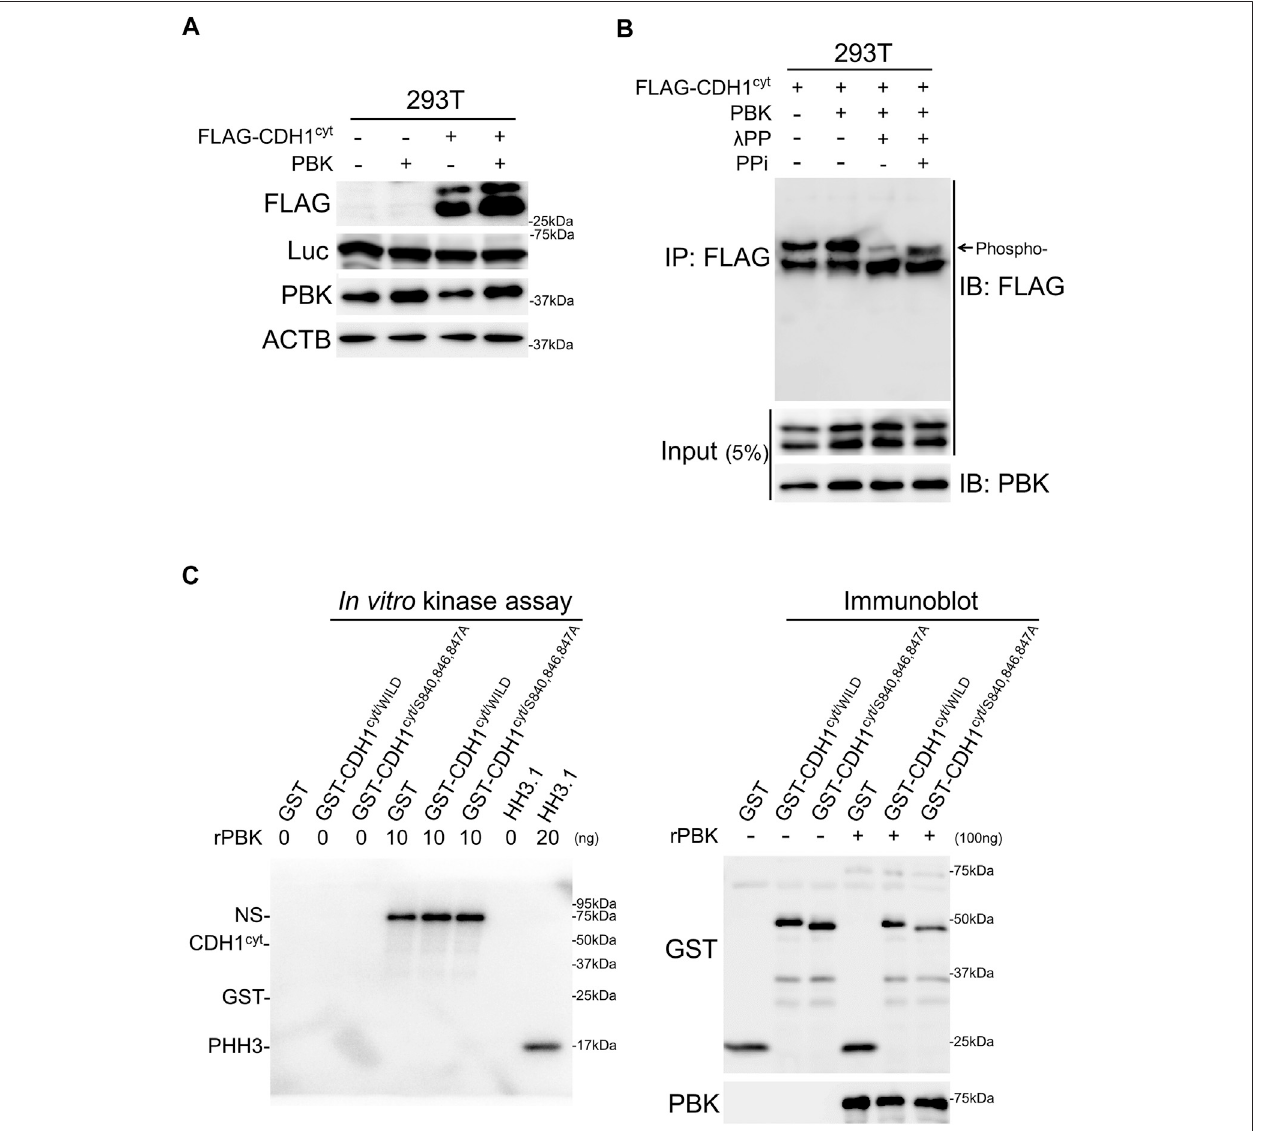
FIGURE4| PBKaccumulatedCDH1ofphosphorylatedformandphosphorylatedhistoneH3. AandB ,immunoblotanalysisshowingPBKaccumulatedCDH1 cyt with phosphorylation. Note that the expression levels of co-transfected Luc were not affected by PBK. (C) , in vitro kinase assay showing that both GST-tagged CDH1 cyt/WILD and CDH1 cyt/S840,846,847A were not phosphorylated by recombinant PBK (rPBK). In contrast, rHH3.1 was directly phosphorylated by rPBK (left panel). Immunoblot analysis showing CDH1 cyt/WILD and CDH1 cyt/S840,846,847A with or without kinase reaction. Note that no band shift was detected after kinase reaction (right panel). NS, non-speci fi